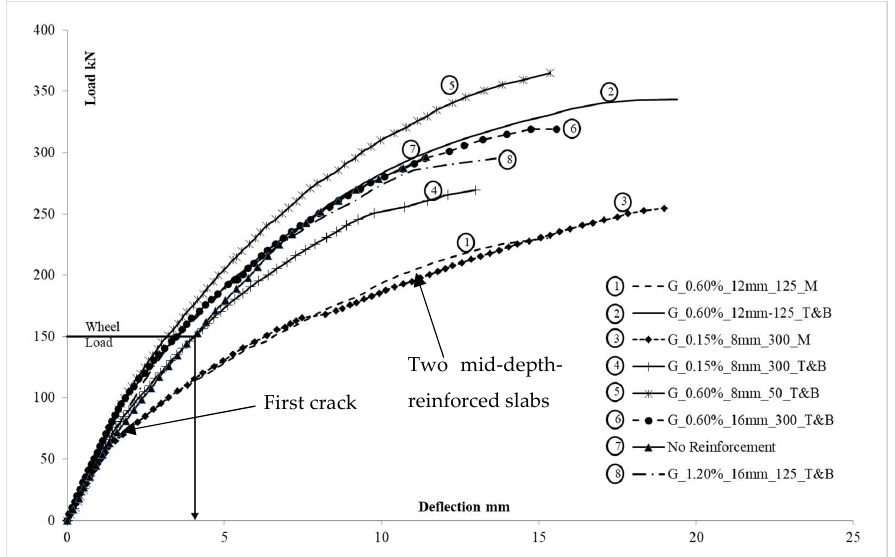
Figure 4. Load vs. deflection behavior of the tested slabs. It can be seen that the ultimate failure load is about two times the maximum tandem system load model 1 (TSLM1) service wheel load of 150 kN.